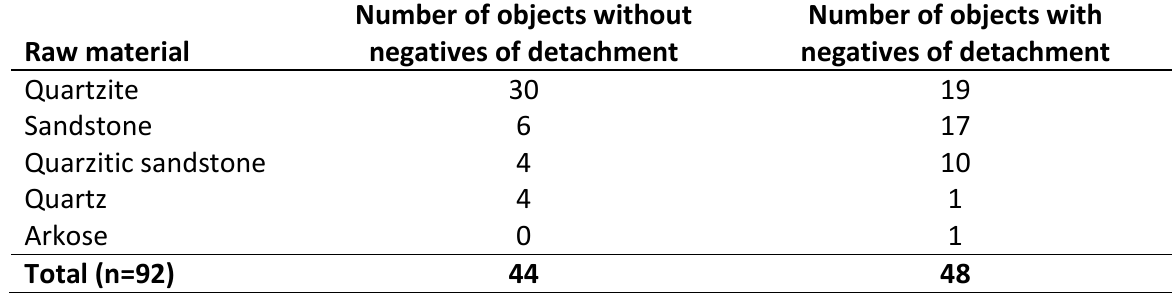
Table 5. Hammerstones from GH 3.